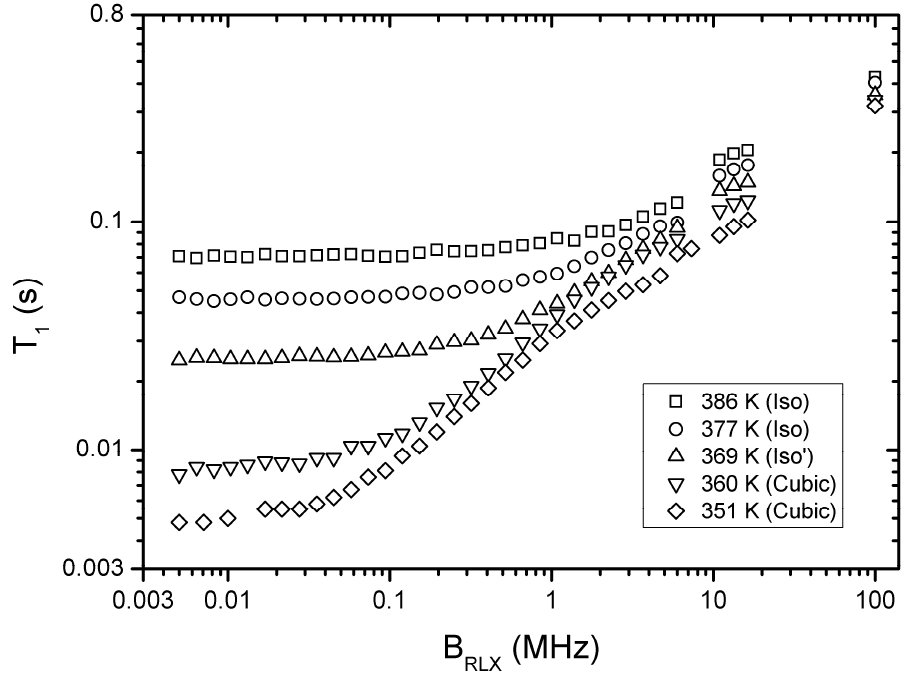
Figure 6. Frequency (MHz) dependence of proton spin-lattice relaxation time T 1 (s) of L1 at some chosen temperatures in the three mesophases: isotropic, isotropic’, and cubic phases.